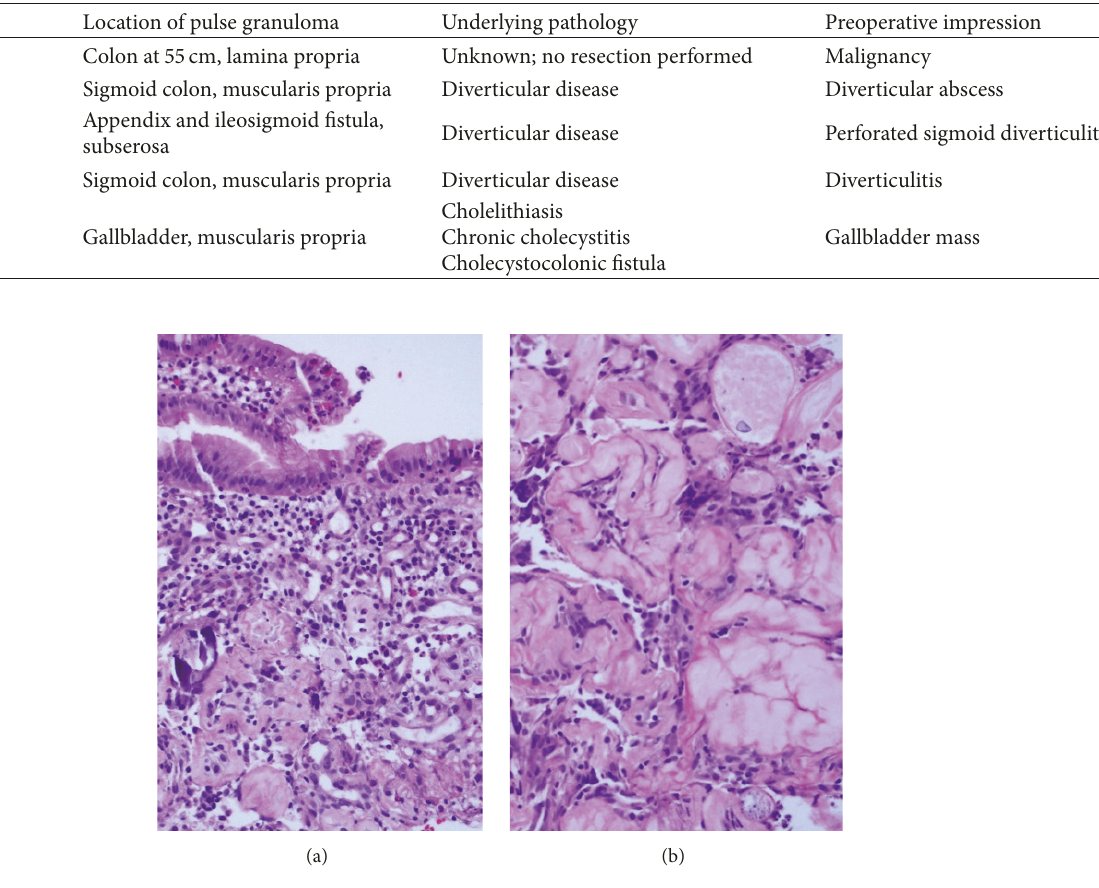
Figure 1: ((a) and (b)) Two examples of pulse granulomas involving the gastrointestinal tract composed of the characteristic dense and eosinophilic hyaline rings ((a) H&E, original magnification × 100, and (b) H&E, original magnification ×